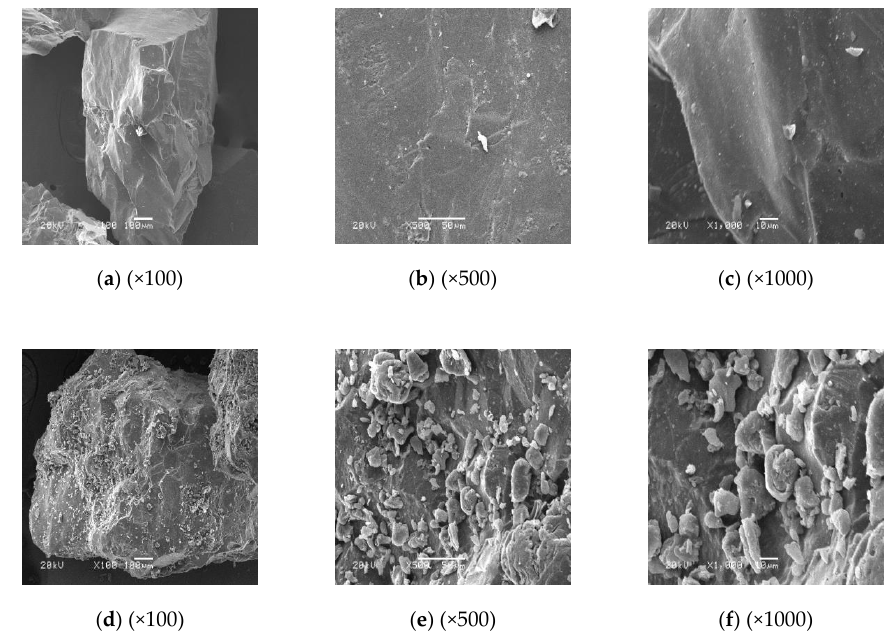
Figure 5. SEM images of ( a – c ) unmodified quartz sand; ( d – f ) CSQS.